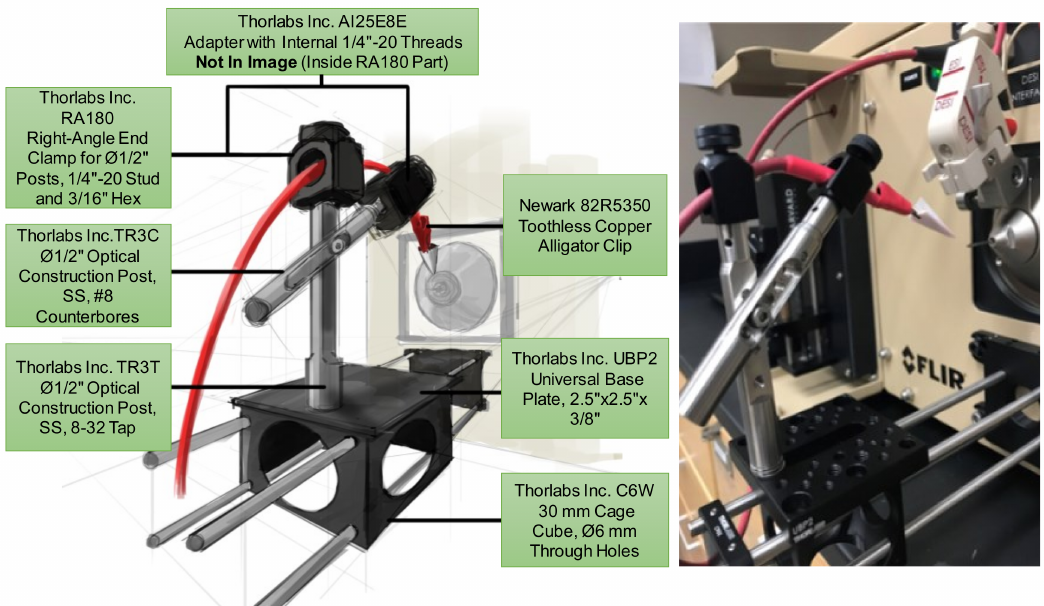
Figure 4. Simplified paper cone spray ionization (PCSI) source module built upon the ThorLabs cage cube for the centralized mounting system. Optical construction posts and adapters allow positioning of the alligator clip that serves to hold the conical ion source volume and supply high voltage. Application of spray solvent to the conical volume allows dissolvation of the bulk sample placed within, followed by spray ionization at the pyramidal egress of the source.